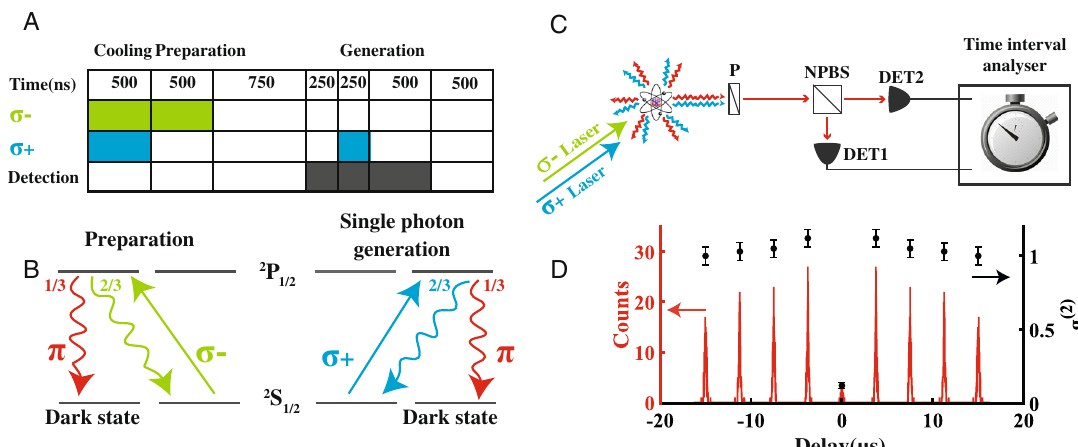
Fig. 2 Single photon generation protocol. a Pulse sequence for σ + and σ − lasers and detection gating. b 174 Yb + level diagram showing π photons result in optical pumping to a dark state. c Experimental set-up of the second order correlation measurement g (2) . Ion fl uorescence is analyzed with a linear polariser (P) to fi lter out σ photons, leaving only π photons to be divided by a 50/50 non-polarizing beamsplitter (NPBS) between two photomultiplier tube detectors (DET1, DET2). Arrival time statistics are accumulated by a digital interval analyzer. d Measured coincidence counts and second-order correlation g (2) . Peak spacing corresponds to 3.25 μ s experimental repetition